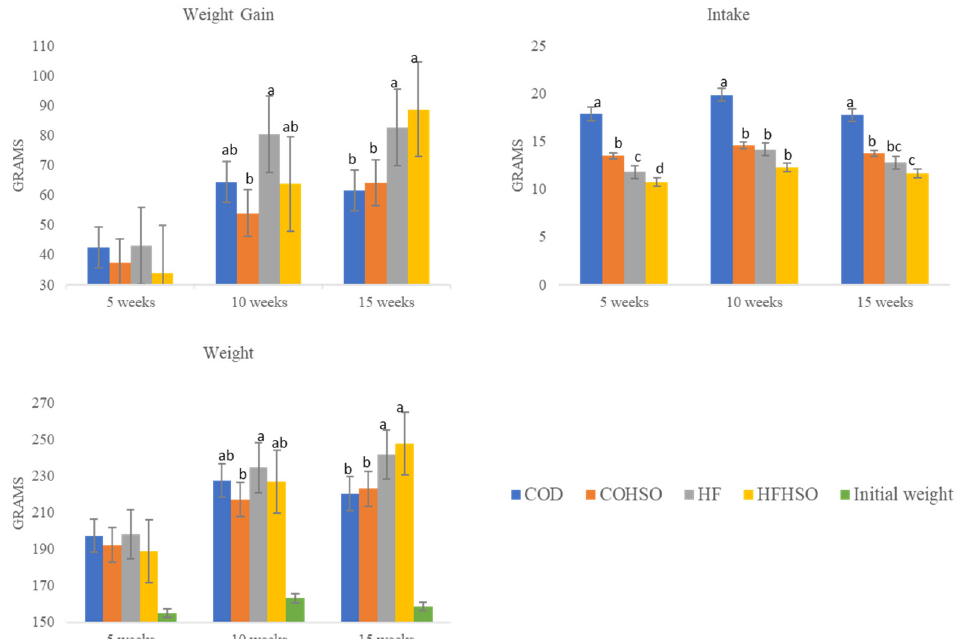
Figure 1. Weight, Weight Gain, and Total Food Intake for Rats. Significant p ≤ 0.05, a: the most significant result. All groups were compared with each other within the same week. The same bar with different superscript letters is significantly different among groups within the same week ( p < 0.05). COD: control diet, COHSO: control diet supplemented with 10% HSO, HF: high-fat diet, HFHSO: high-fat diet supplemented with 10% HSO, HSO: hemp seed oil.